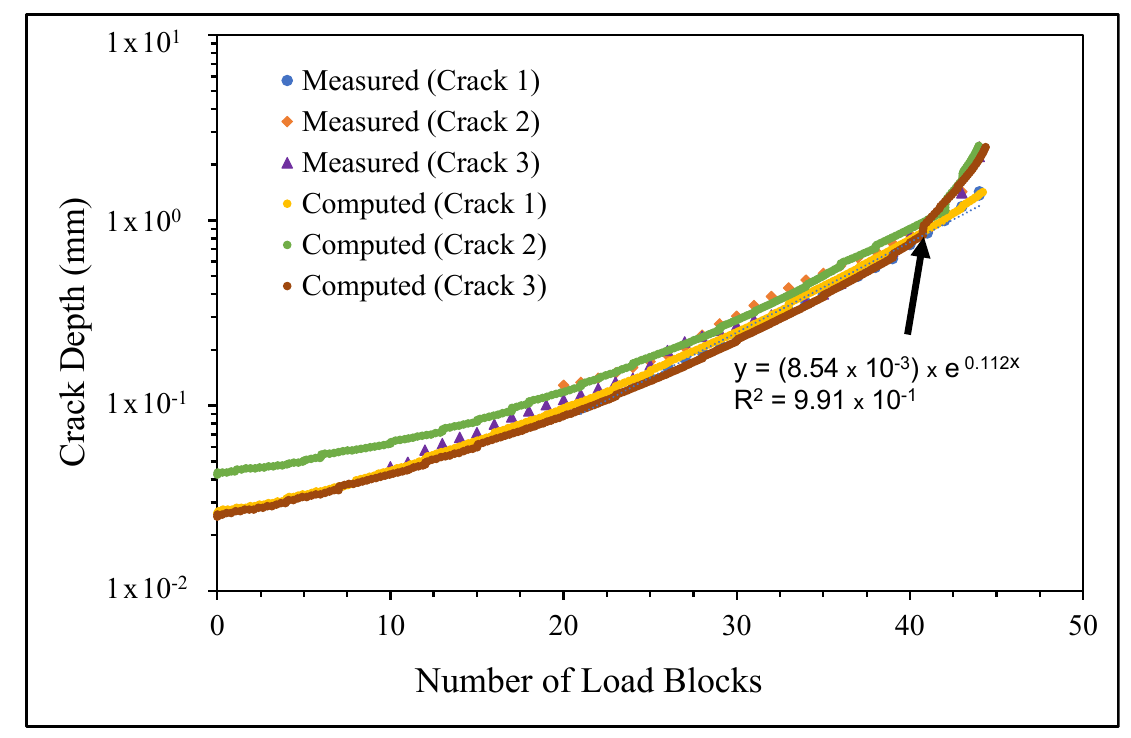
Figure 9. Measured and computed crack growth histories for specimen 2.